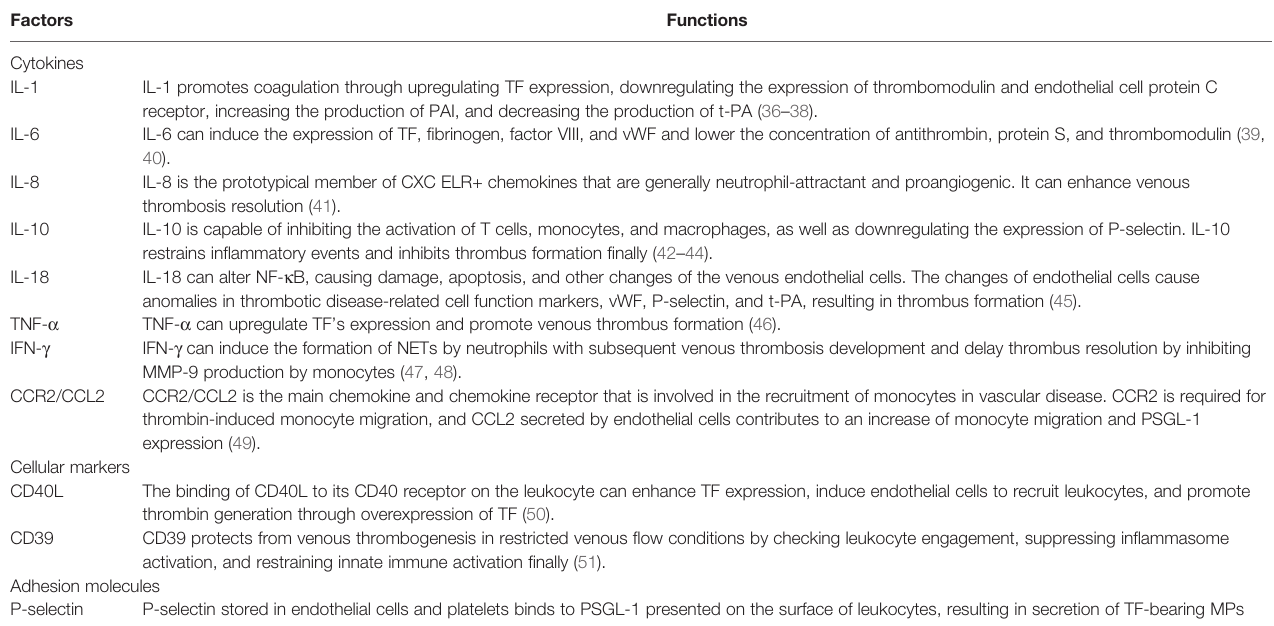
TABLE 1 | Proin fl ammatory factors implicated in venous thrombosis formation and development. Factors Functions Cytokines